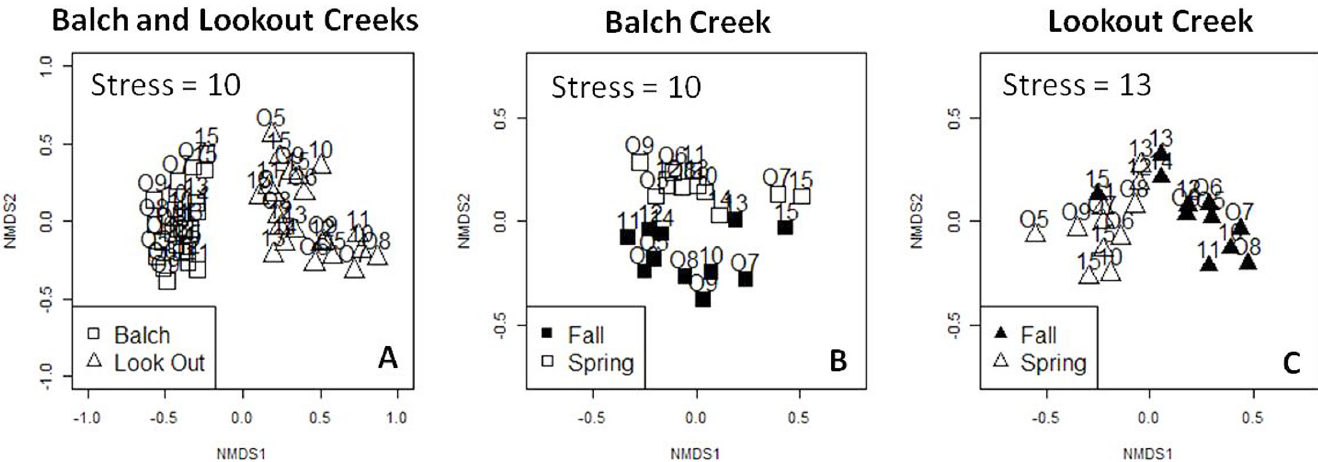
Fig 6. Ordinations for both streams (Panel A), Balch Creek (Panel B) and Lookout Creek (Panel C). Participants generated data for the ordinations by sampling the same reach biannually from 2005 – 2015. Season is indicated for fall (filled symbol) and spring (open symbol) samples. The two-digit number indicates sampling